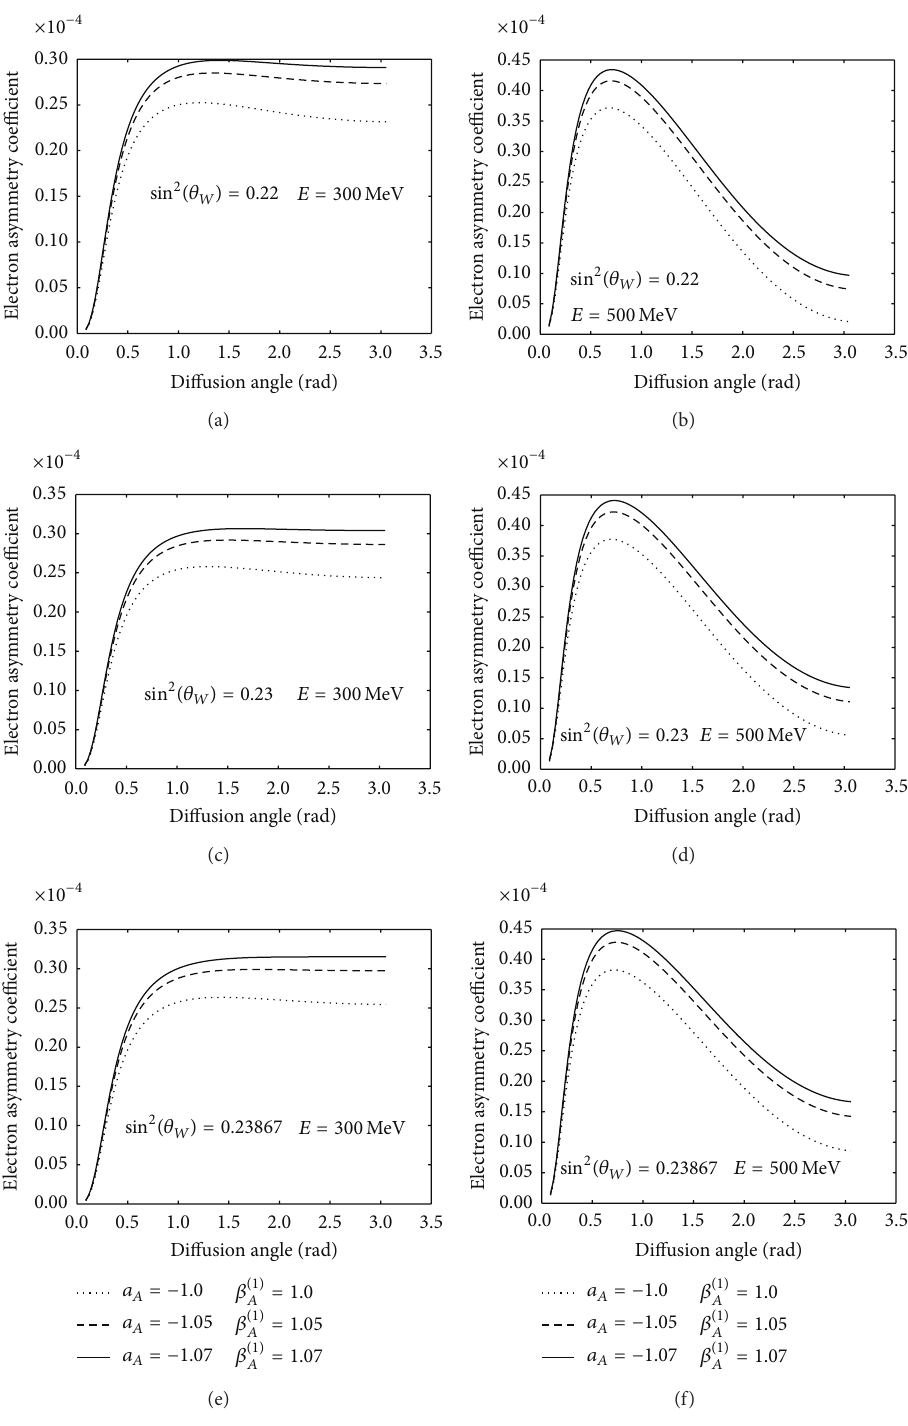
Figure 2: Asymmetry coefficient for the